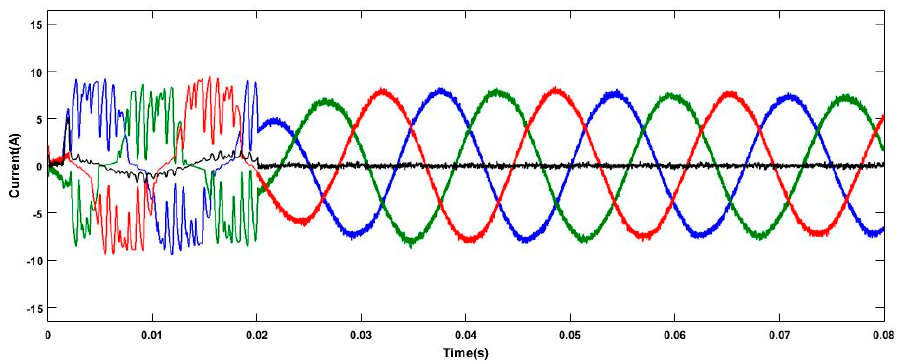
Figure 9. Compensation result with the proposed control strategy for case 1. Table 1. Compensation results for case 1.